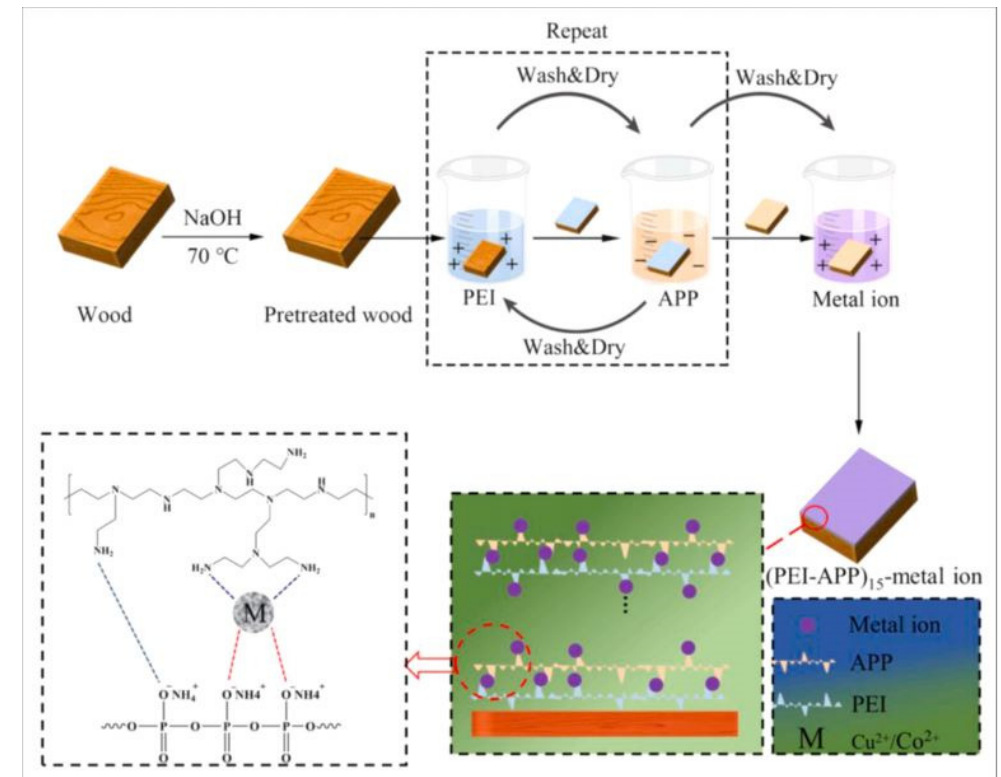
Figure 5. Schematic diagram of flame-retardant coating construction and metal–ion crosslinking effect [64].